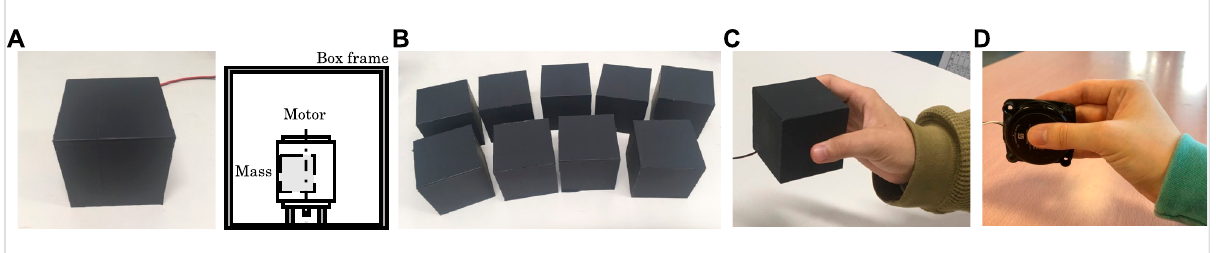
FIGURE 1 (A) Vibrating box and its schematic diagram. An eccentric mass vibration motor present inside the box makes the box vibrate. (B) Non-vibrating boxes that are identical to the vibrating box in appearance, but with different weights. (C) Lifting the box with fi ve fi ngers in Experiment 1. (D) Lifting the voice coil oscillator in Experiments 2 and